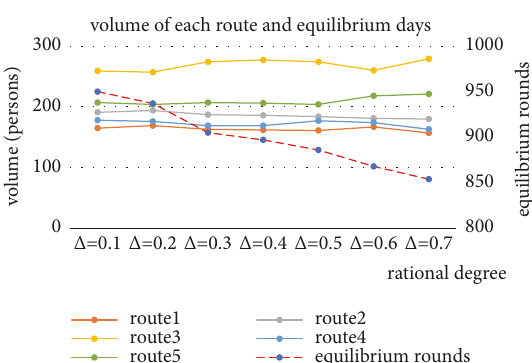
Figure 2: Road network.